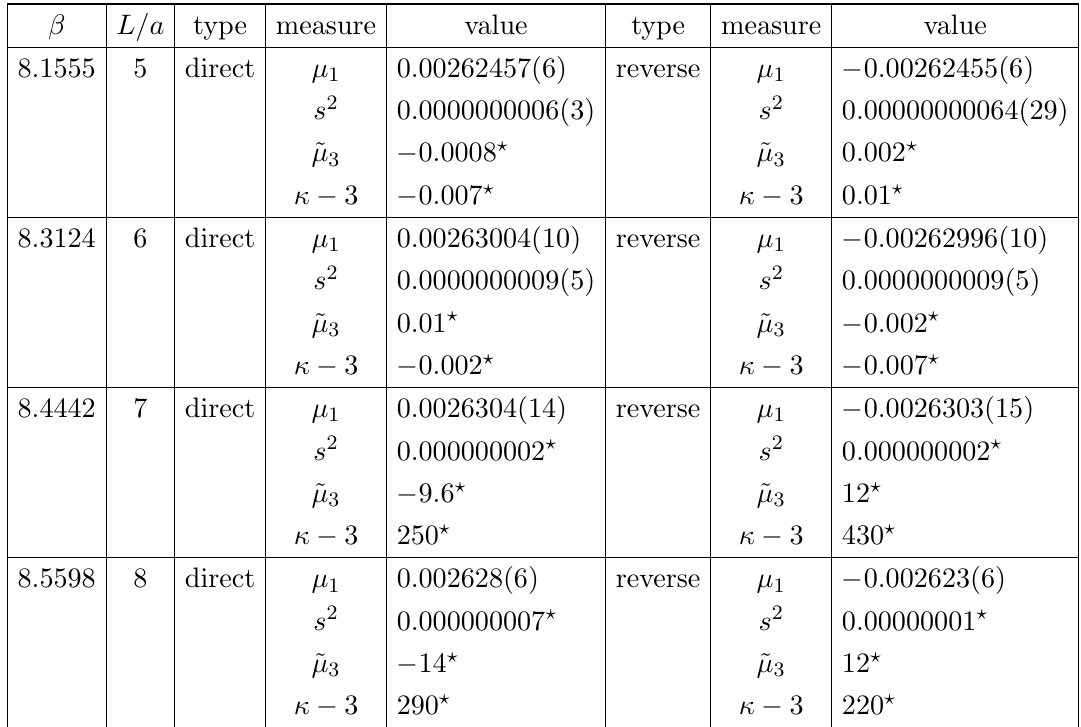
Table 18 . Same as in table 17, but for our simulations of SU(3) Yang-Mills theory summarized in the lower left-hand-side block of table 9, with (cid:1) (cid:17) = 0 : 0001 and n